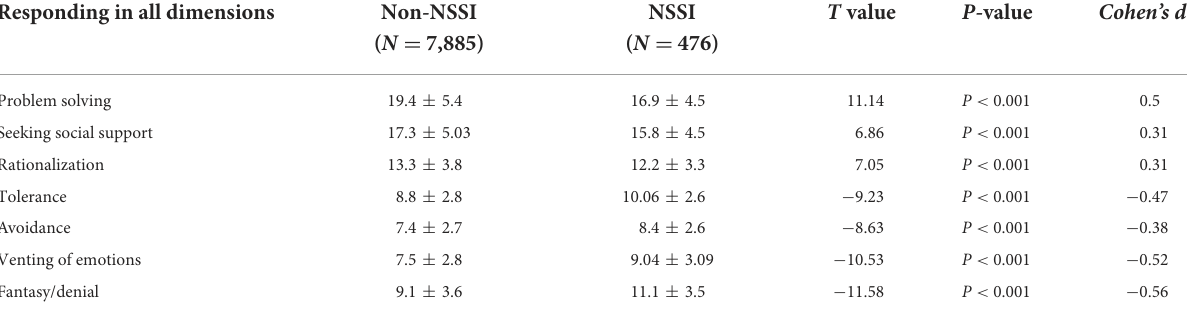
TABLE 2 Comparison of students’ scores on the dimensions of coping styles in the no NSSI and NSSI groups ( x ± s). Responding in all